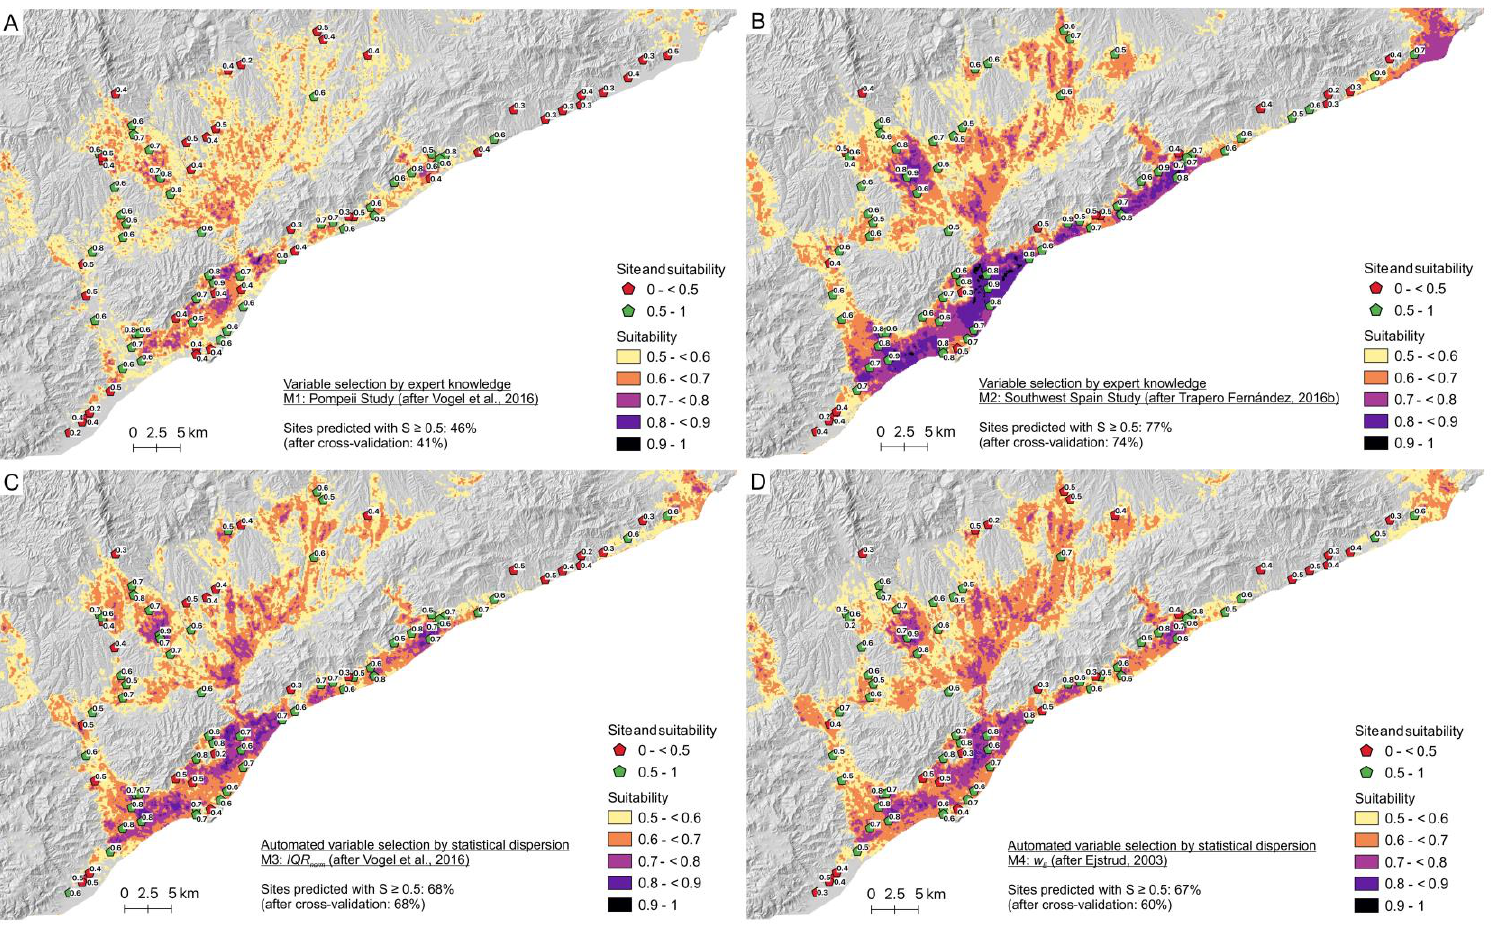
Figure 9. Suitability maps of predictive models with variable selection based on expert knowledge ( A : M1 — Pompeii Study (after Vogel et al. [8]); B : M2 — Southwest Spain Study (after Trapero Fernández [10])) and on statistical dispersion (C: M3 — IQR norm (after Vogel et al. [8]); D: M4 — w E (after Ejstrud [52])). Labels on white background refer to rounded predicted S values for the respective archaeological sites.